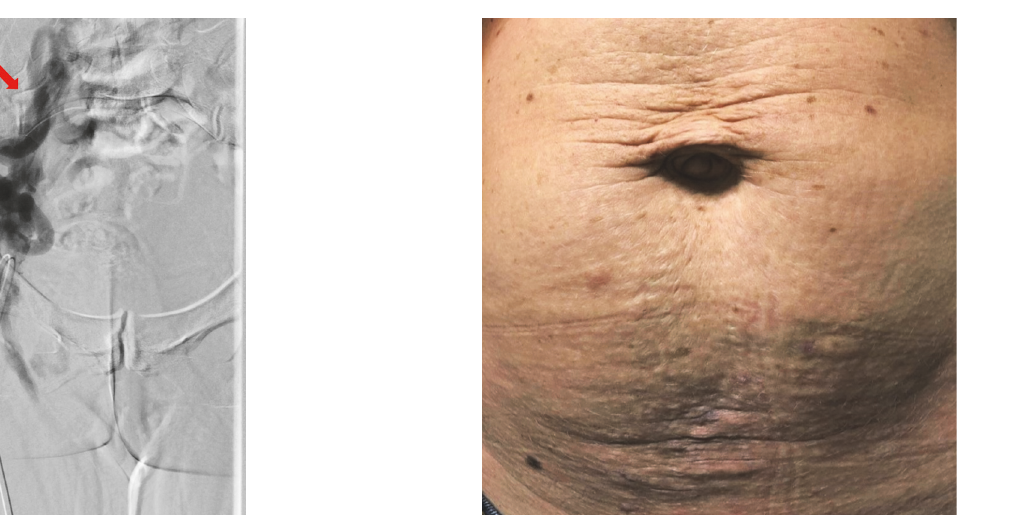
Figure 4: Successful stab phlebectomy and ultrasound-guided sclerotherapy resulted in complete resolution of the symptomatic